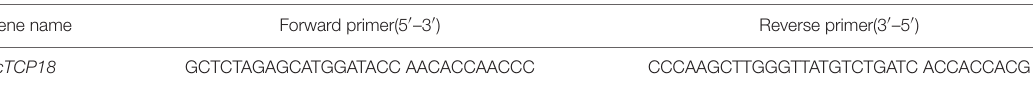
TABLE 2 | Primers for cloning